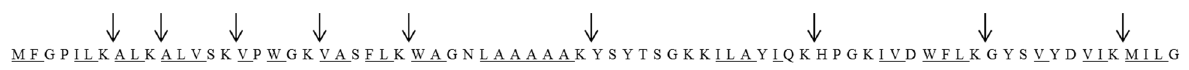
Fig. 4 The amino acid sequence analysis of AMEP412. Arrows point to the cleave sites of trypsin; underlined means the hydrophobic amino